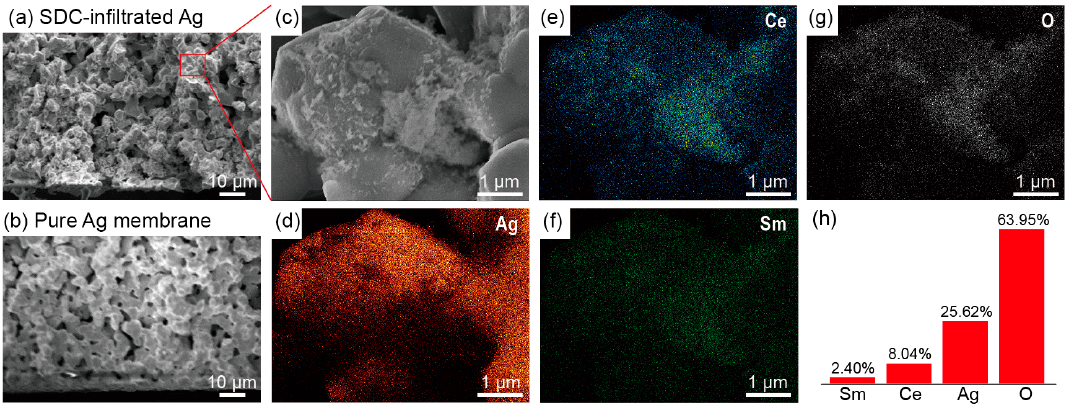
Figure 2. Cross-sectional FESEM images of ( a ) SDC-infiltrated Ag membrane fired at 700 °C and ( b ) pure Ag membrane. ( c – g ) EDS mappings of SDC-infiltrated silver membrane. ( h ) Atomic ratio of SDC-infiltrated Ag membrane.